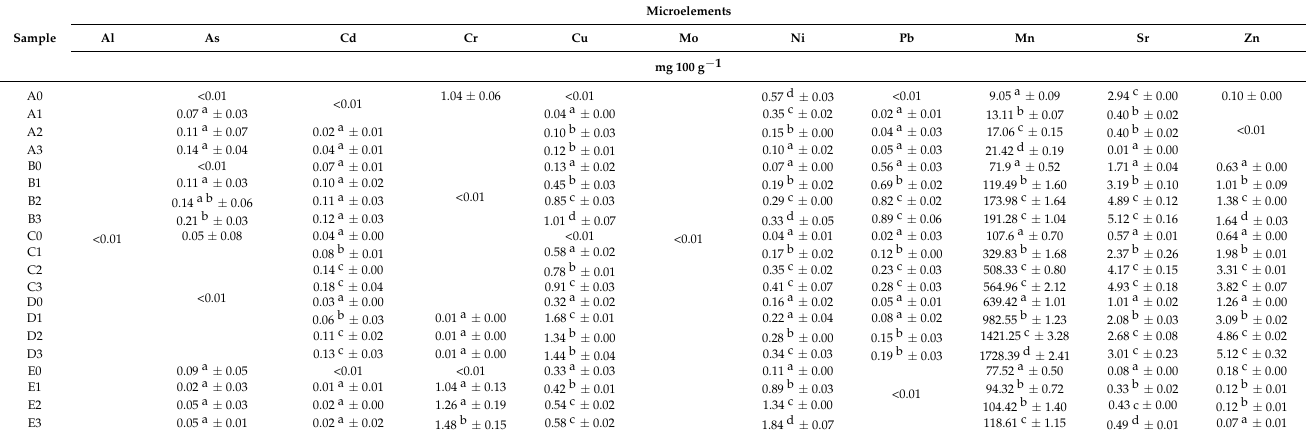
Table 6. Content of selected micronutrients and heavy metals in oak biomass and its